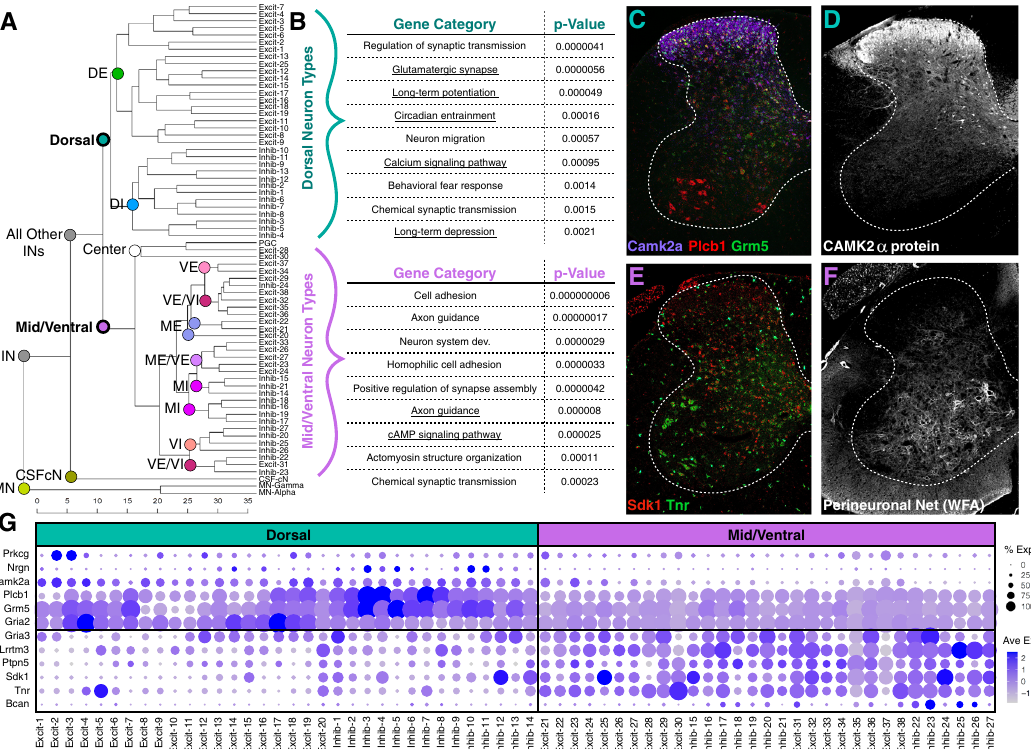
Fig. 3 Trends in dorsal-ventral organization of spinal cord neuron types. a Dendrogram showing the relationships between the 69 neuronal cell types based on their distance from each other in the 50-dimensional principal component (PC) space. MN motoneuron, IN interneurons (and projection neurons), CSF-cN cerebrospinal fl uid contacting neurons, DE dorsal excitatory, DI dorsal inhibitory ME mid excitatory, MI mid inhibitory, VE ventral excitatory, VI ventral inhibitory, center represents a group of 3 cell types located near lamina X – the center of the spinal cord. b Differential gene expression tests (ROC) were used to compare overall gene expression between the dorsal cell types and mid/ventral cell types and signi fi cant gene lists were analyzed by gene ontology (GO) term searches with GO DAVID using molecular function and biological process terms, as well as KEGG pathway lists (which are underlined) and the top terms for each cell class are shown. c – f Validation of differentially expressed genes using RNA in situ hybridization ( c , e ), antibody staining ( d ), or WFA-lectin staining ( f ). 20x tiled images, with brightness and contrast adjusted. All images are representative of the pattern observed in at least 3 sections each from N = 3 animals. Scale bars are 200 μ m. g Dot plots showing expression of plasticity-related genes in each harmonized cluster, in which dot color intensity corresponds to average expression level (Ave Exp) and dot size corresponds to the percent of each cluster that expressed the gene (%